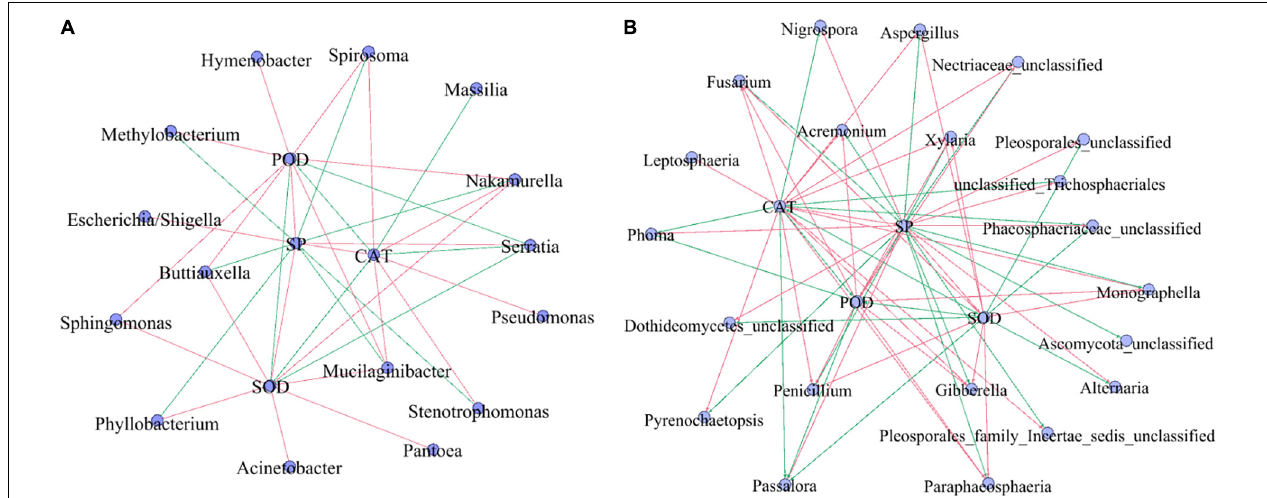
FIGURE 7 | The correlation analysis among SP, antioxidant enzyme (SOD, POD, and CAT), and top 30 bacterial (A) and fungal (B) populations. SP, soluble protein; CAT, catalase; SOD, superoxide dismutase; POD, peroxidase. Red line: negative correlation, green line: a positive correlation. The correlation among SP, antioxidant enzyme (SOD, POD, and CAT), and top 30 microbial populations (genera) by the Pearson methods at p < 0.05. Standardization method: standardize environmental data only (scale each factor to zero mean and unit